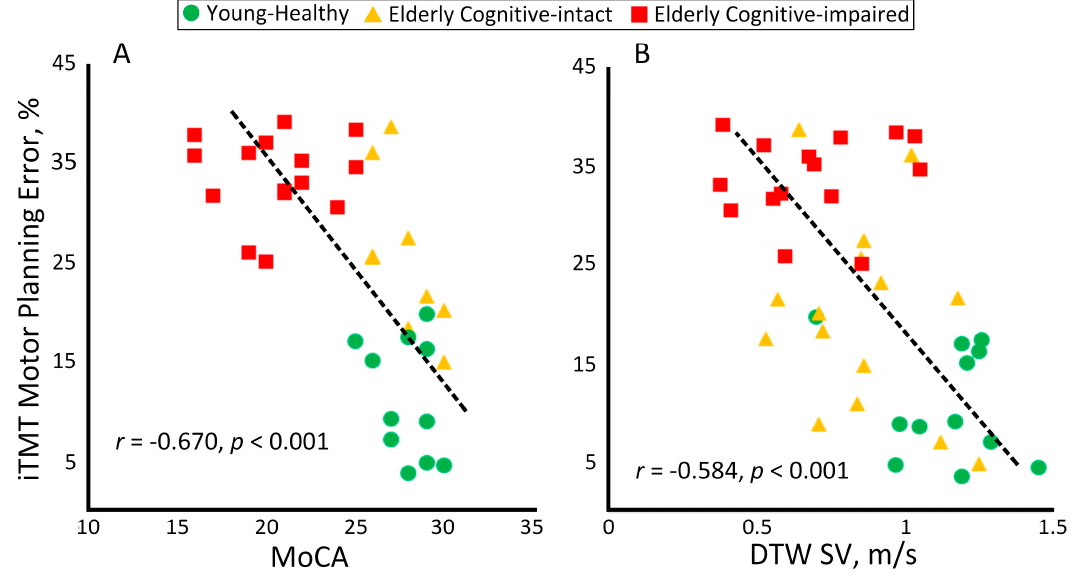
Figure 4. Correlation between the iTMT MPE and ( A ) MoCA test score and ( B ) dual task walking stride velocity (DTW SV).